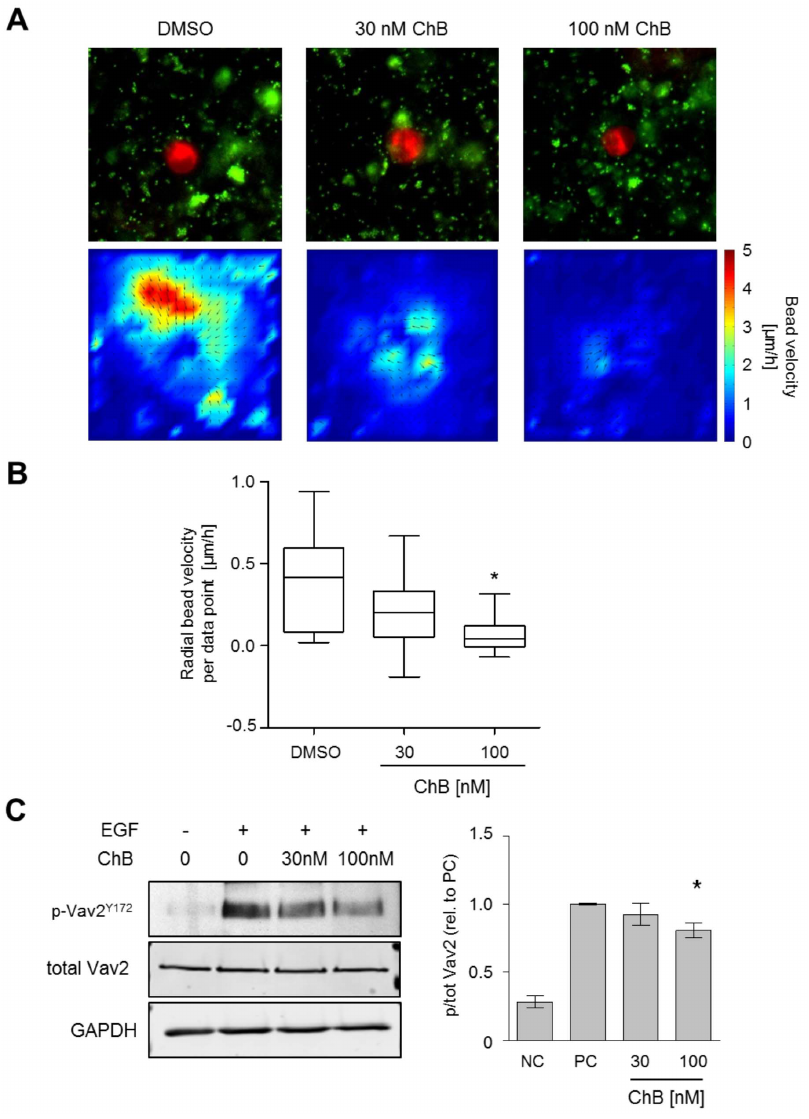
Figure 6. Chondramide diminishes contractility. (A) MDA-MB-231 cells were pretreated for 24 h as indicated, embedded in matrigel containing fluorescent beads and pictures were taken over 4 h every 15 min. Cellular, contractile force on the surrounding matrix was visualized via bead movement towards the cell and analyzed using PIV analysis. Upper panel: Representative images of cells (red) and fluorescent beads (green) t=0. Lower panel: PIV analysis of bead velocity in the 2D projection. Color codes show bead velocity indicating applied force. Direction of vectors indicates averaged direction of bead movement. (B) For quantitative analysis the radial velocity (bead velocity towards the cell center) per data point was calculated. Minimum 13 cells per condition were analyzed. *, p , 0.05 One-way ANOVA, Tukey post-test. (C) Phosphorylation of the Rho-GEF Vav2 was tested via Western blot analysis upon EGF stimulation (n=3); * p , 0.05 vs. control, One-way ANOVA, Tukey post-test.